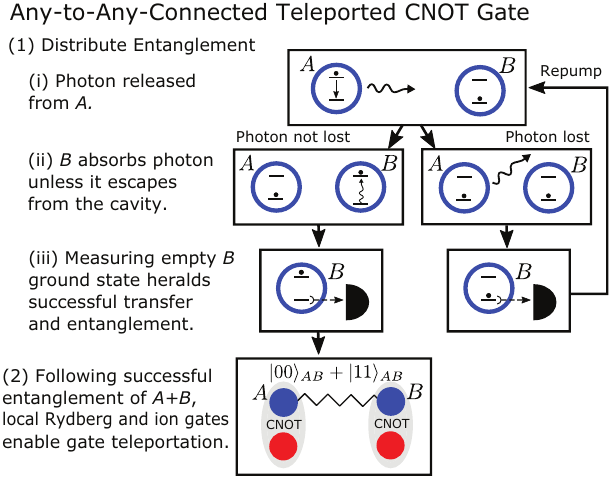
FIG. 2. Heralded photon transfers create entanglement between distant communication qubits. Subsequent high-fidelity local operations enable teleported quantum gates between distant memory qubits.